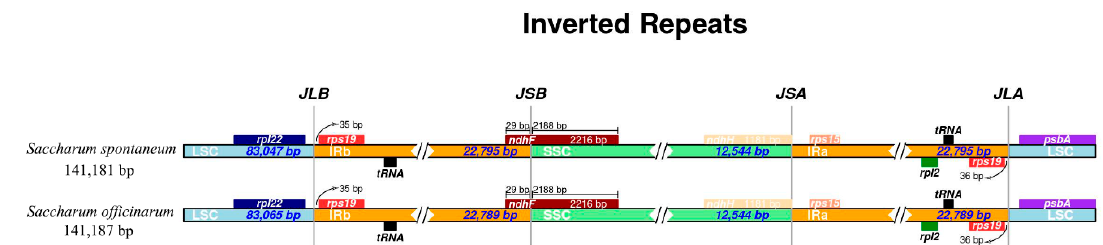
Figure 6. Comparison the junctions of the large single copy (LSC), small single copy (SSC) and inverted repeats (IRs) in chloroplast genomes of Saccharum officinarum and S. spontaneum. Among them, JLB stands for the joint of LSC/ IRb, JSB for the joint of SSC/ IRb, JSA for the jint of SSC/ IRa, and JLA for the joint of LSC/IRa.